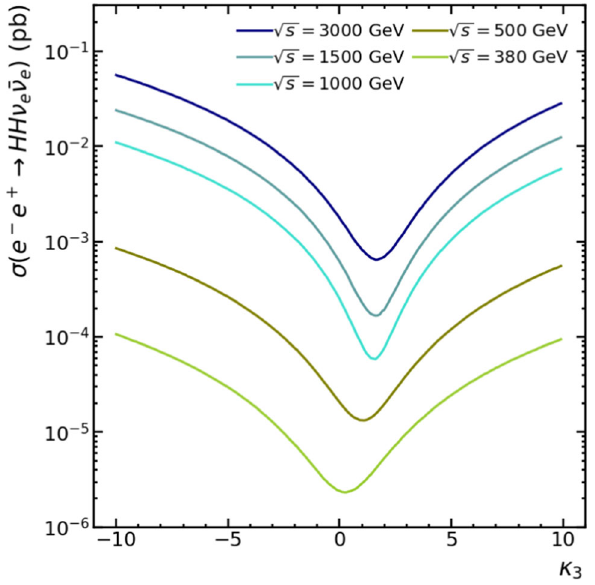
Fig. 24 Total cross section of e + e − → H H ν e ¯ ν e as a function of κ 3 , with κ 4 set to 1, for different values of the CM energy